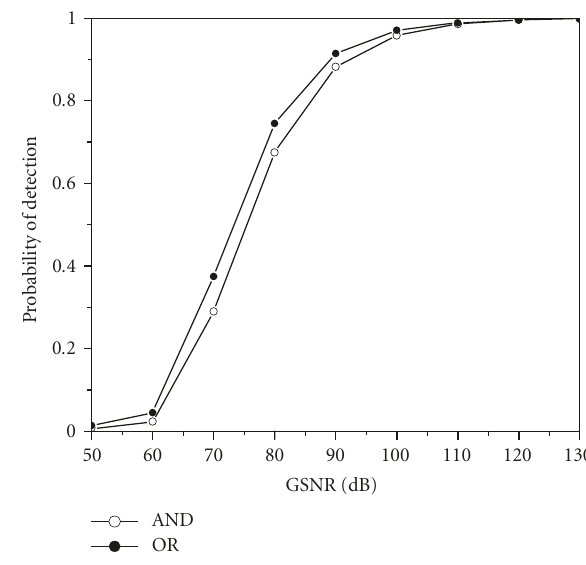
Figure 6: Probability of detection of two distributed CA CAGOC- FAR system in homogeneous Pearson background adopting the “AND” and “OR” fusion rules. N 1 = N 2 = 32. P fa = 10 − 4 .